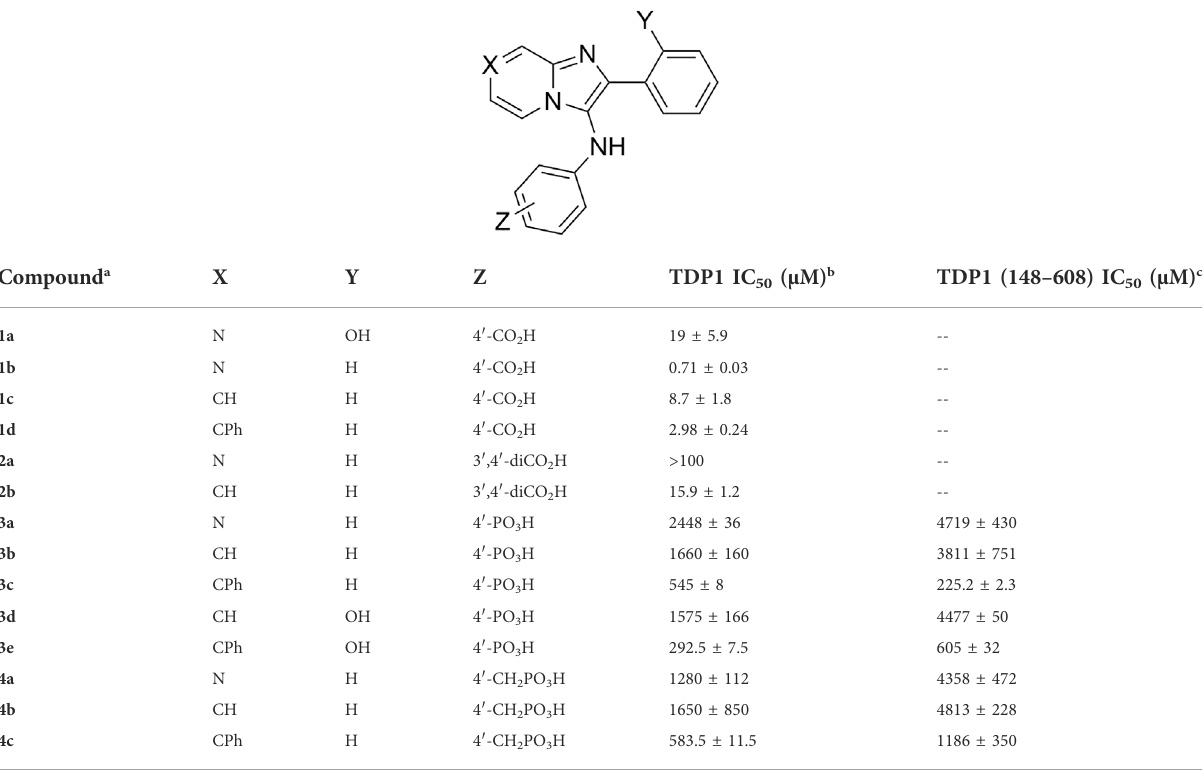
TABLE 1 Structures and inhibitory potencies of TDP1 inhibitors in gel-based fl uorescence assay with full-length TDP1 or TDP1 (148 – 608) in vitro .